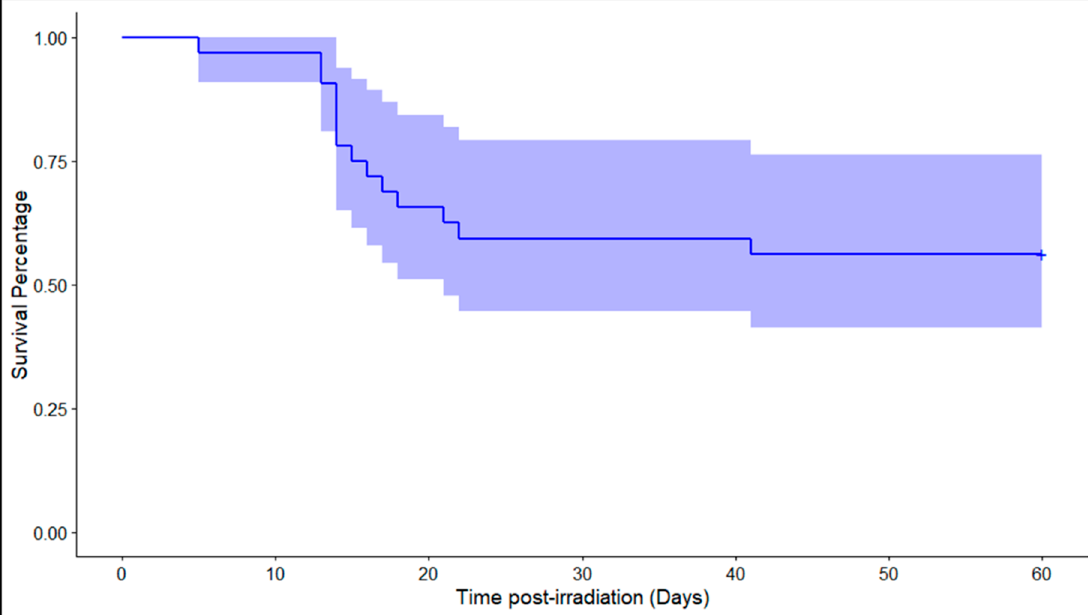
Figure 1. Percent survival for the nonhuman primate (NHP) study cohort over the course of 60 days of the follow-up